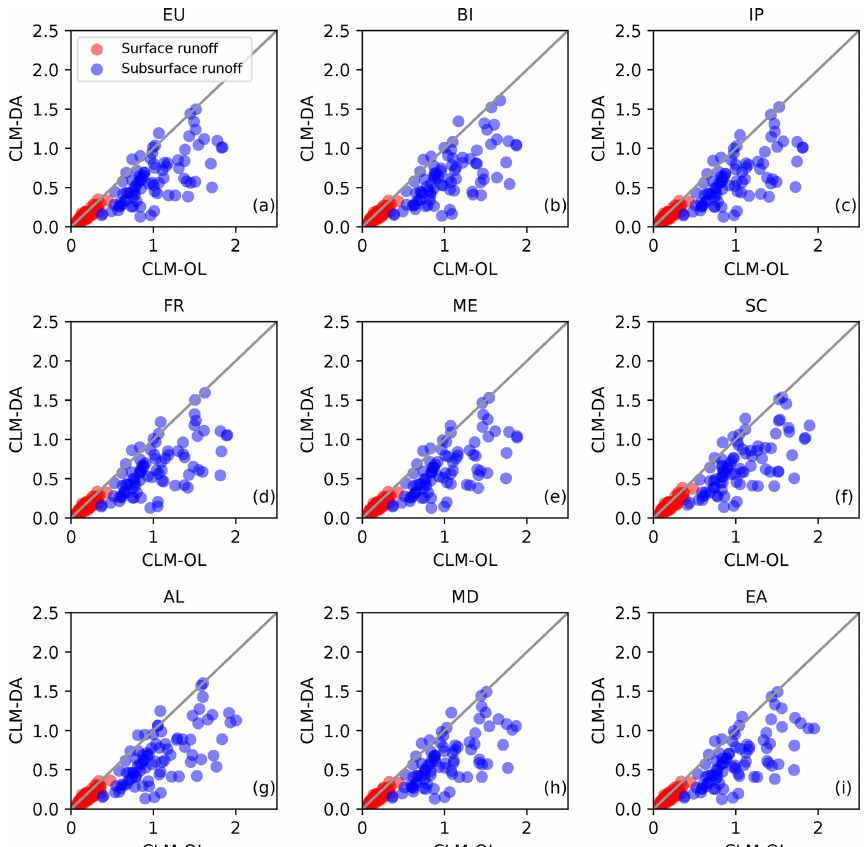
Figure 11. Comparison of spatially averaged monthly simulated runoff components (surface and subsurface runoff) between CLM-OL and CLM-DA over Europe and PRUDENCE regions for the time period of 2000–2006. Grey line represents 1 : 1